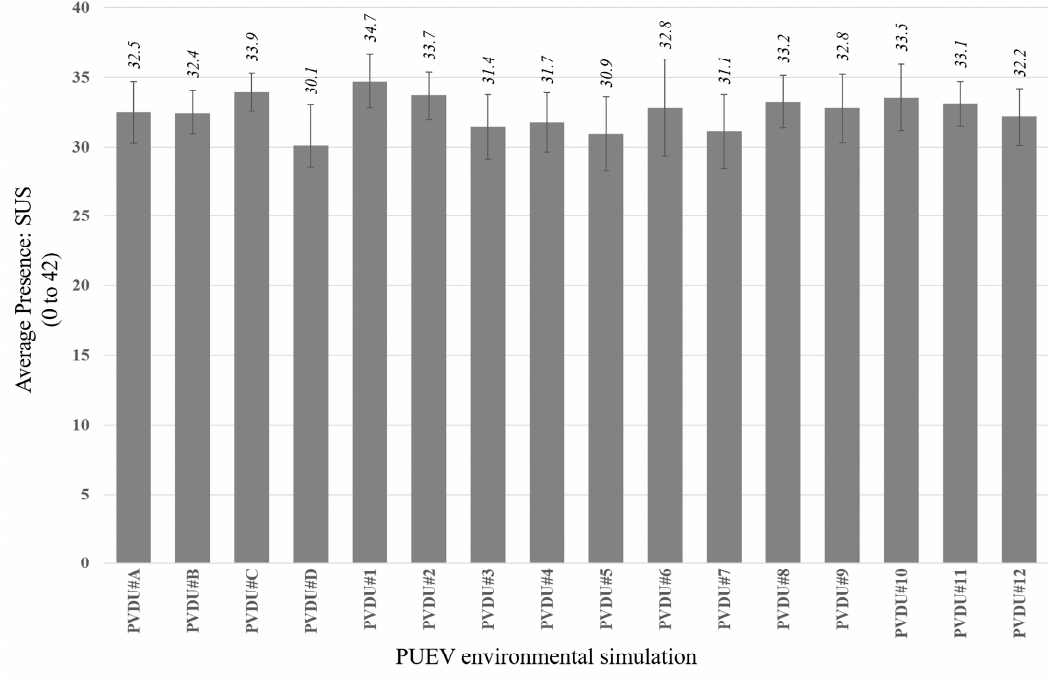
Figure 4. Average level at 95% confidence interval for presence mean in each PUDV simulation.